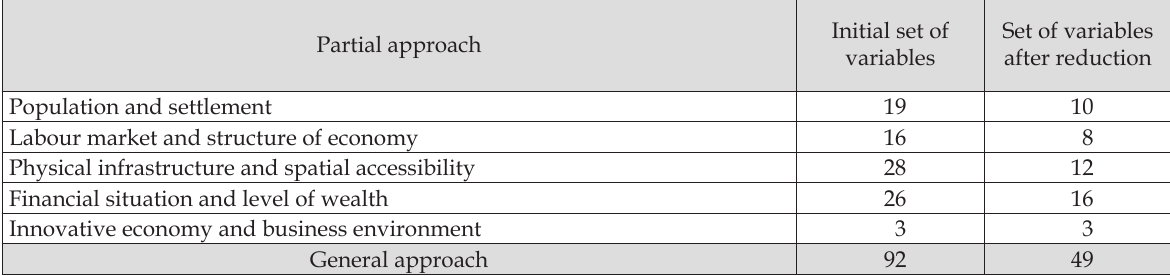
Table 2. Structure of the reduced geographical observation base adopted for the local (NUTS 4)